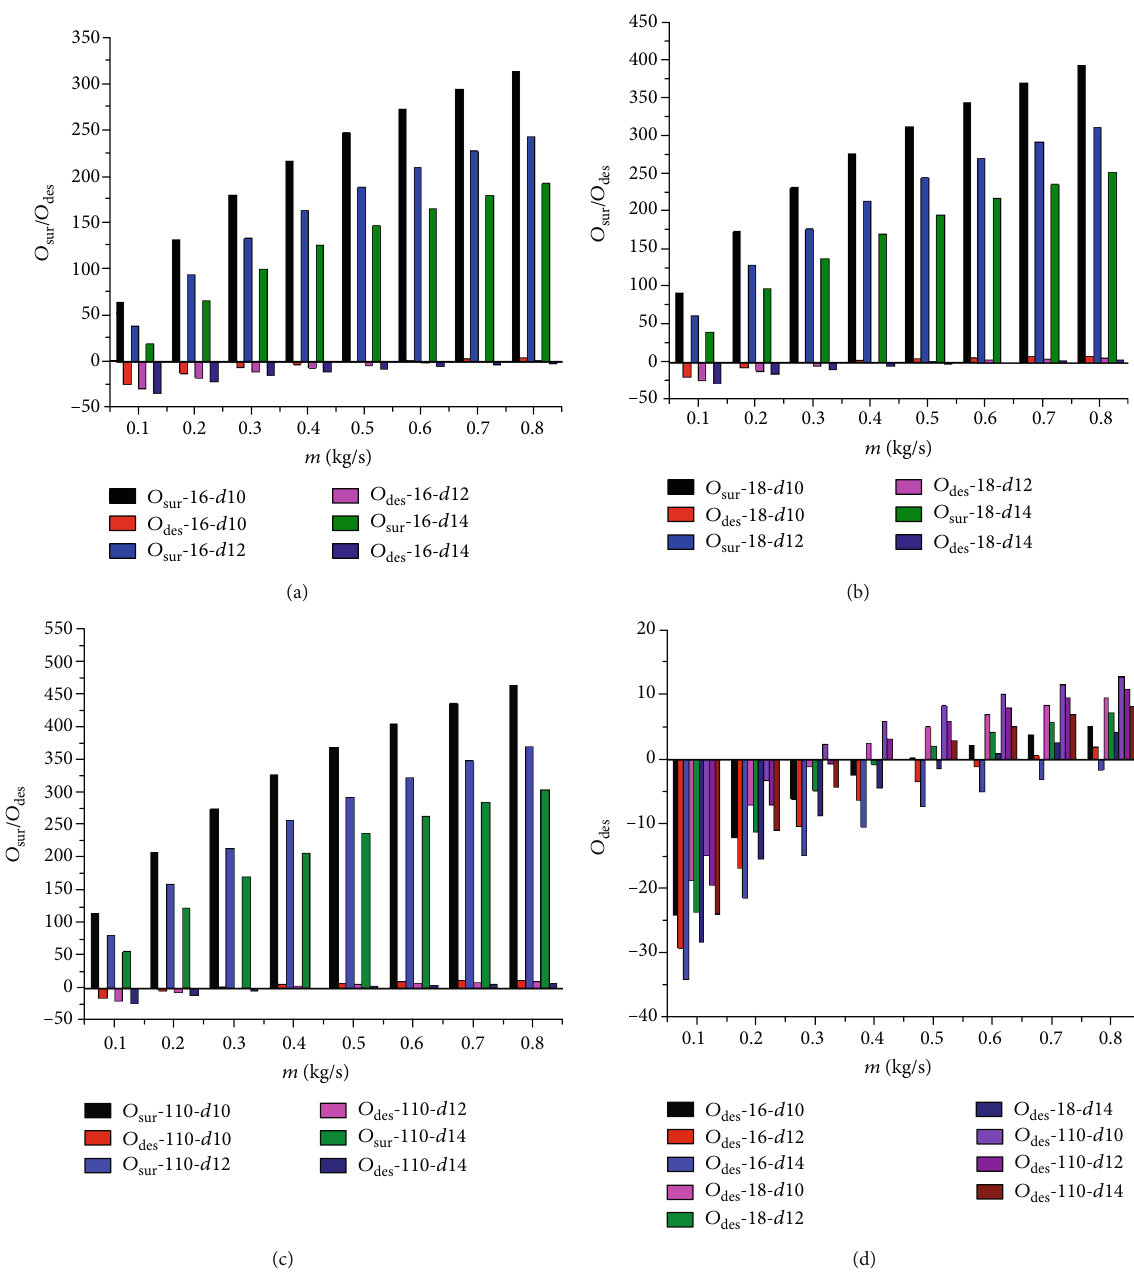
Figure 6: Oversurface and overdesign versus mass fl ow rate: (a) 600mm length, (b) 800mm length, (c) 1000 mm length, and (d) overdesign among all con fi